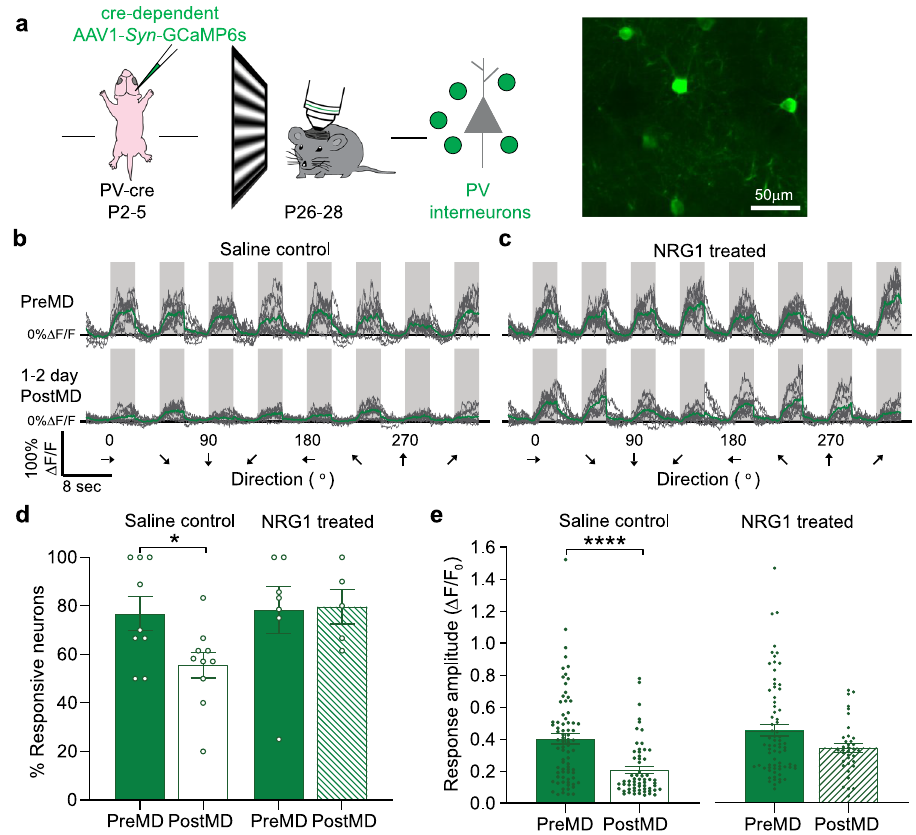
Fig. 1 Sensitivity of juvenile PV interneurons to brief MD depends on NRG1 signaling. a Left: schematic of experimental design for viral labeling PV interneurons in neonates at postnatal days (P) 2 – 5 and Ca 2 + imaging in critical period animals at P26-28. Right: in vivo image of visually responsive PV interneurons (green). Scale bar = 50 µ m. This experiment was performed independently in eight animals total (6 saline group, 2 NRG1 group). b Visually evoked responses of PV interneurons through the deprived eye before and after monocular deprivation (MD) in saline controls. c Visually evoked responses of PV interneurons through the deprived eye before and after MD in neuregulin 1 (NRG1) treated mice. d 1D MD signi fi cantly decreased the percent of responsive PV interneurons (PreMD: n = 9 fi elds from 3 mice, solid green; PostMD: n = 10 fi elds from 3 mice, open green; * p = 0.027, t -test with Welch ’ s correction, two-tailed). Exogenous NRG1 prevented the reduction in PV cell responsiveness (PreMD: n = 7 fi elds from 2 mice, solid green; PostMD: n = 5 fi elds from 2 mice, dashed green; p = 0.876, Mann – Whitney U -test, two-tailed). e 1D MD also reduced the response amplitude of PV interneurons through the contralateral, deprived eye stimulation ( Δ F / F 0 : PreMD, 0.401 ± 0.031, n = 78 cells from 5 mice, solid green; PostMD, 0.205 ± 0.022, n = 61 cells from 3 mice, open green; **** p = 0.00000046, Mann – Whitney U -test, two-tailed). Exogenous NRG1 blocked the reduction in response amplitude of PV interneurons. ( Δ F / F 0 : PreMD, 0.449 ± 0.035, n = 73 cells from 3 mice, solid green; PostMD, 0.342 ± 0.028, n = 36 cells from 2 mice, dashed green; p = 0.266, Mann – Whitney U -test, two-tailed). Data in d and e are mean ±